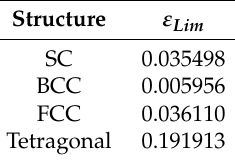
Table 2. Limit Porosity Value ε Lim calculated numerically for each structure.